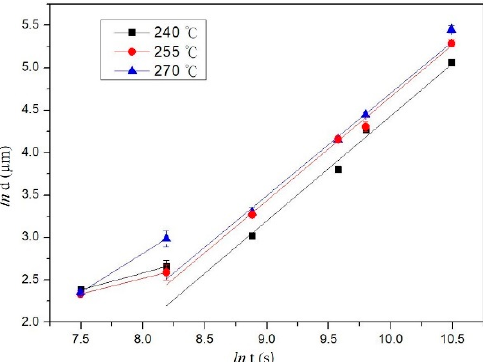
Figure 9. The plot of ln t vs. ln d of Cu 6 Sn 5 phase at different reaction temperatures in the SC/C194 reaction couple.